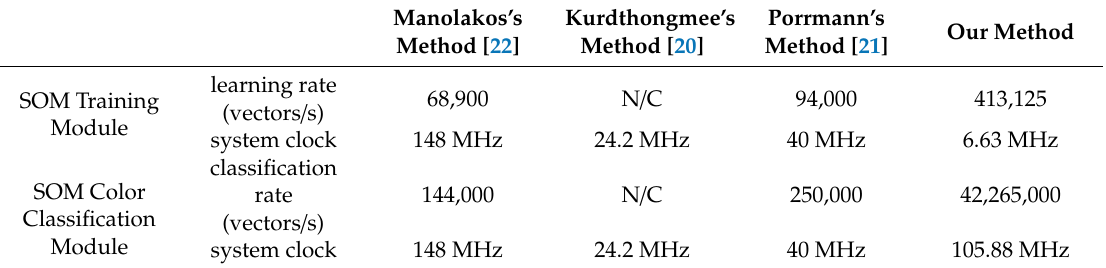
Table 4. Performance comparison with exiting SOM hardware architectures.